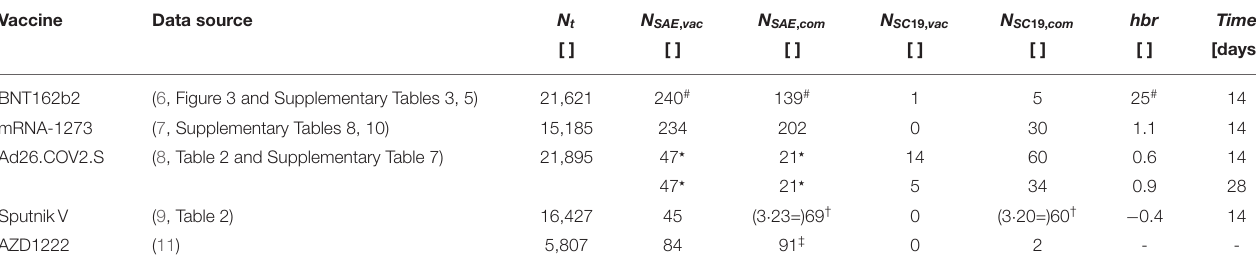
TABLE 1 | Absolute counts of severe adverse events, N SAE , and severe cases of CoViD-19, N SC 19 , each for the vaccine (index “ vac ”) and the comparison (mostly: placebo) group (index “ com ”), as documented by the phase-3 studies (data source); the harm-to-benefit ratio hbr resulting from these counts, and the Time after full vaccination, when the count, until the end of the study, of CoViD-19 cases began; N t documents the number of subjects in the vaccine group.